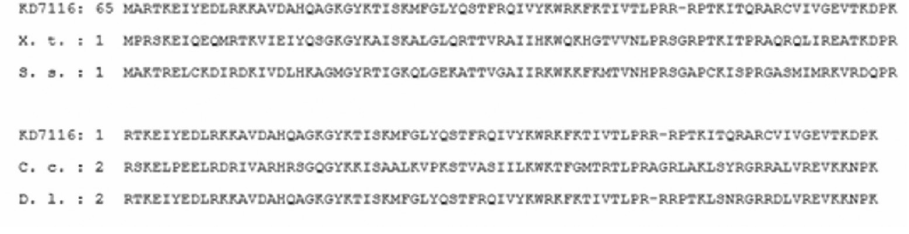
Figure 3. Comparison of the amino acid sequence of Transposase expected of AnDraI with Tc1-like transposase of other species. X. t. Xenopus tropicalis S. s. Salmo salar C. c. Cyprinus carpio D. l. Dicen- trarchus labrax